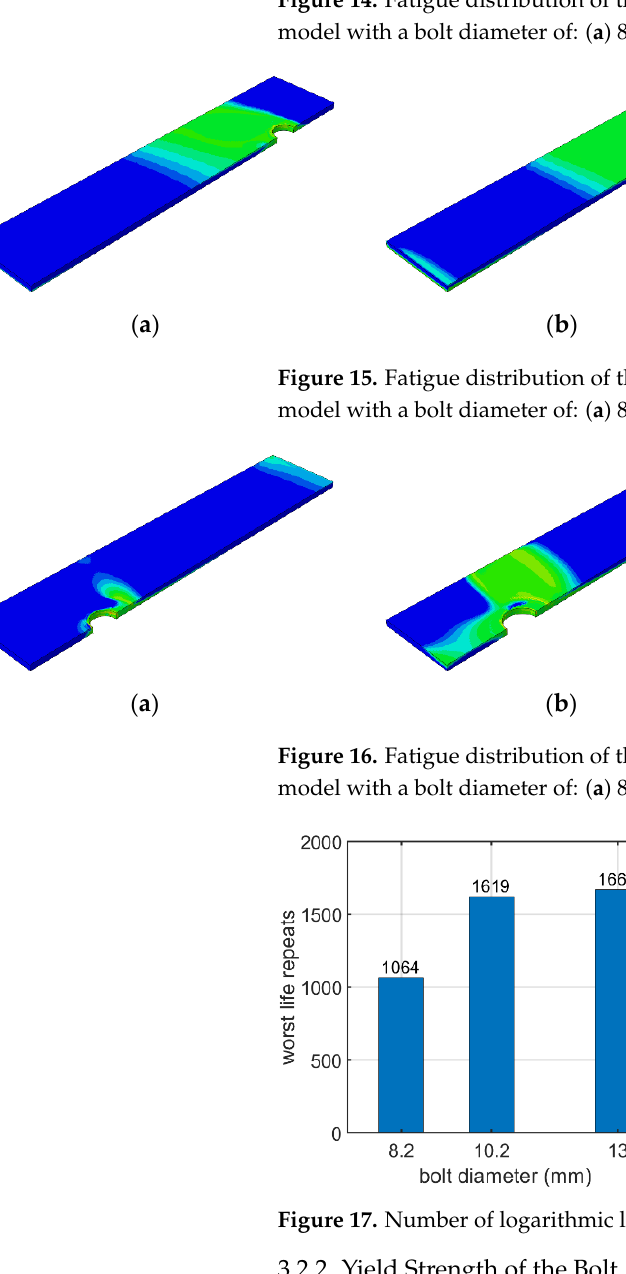
Figure 18. Number of logarithmic life repeats for parameterizing the yield stress of the nutless bolt. 3.2.3. Coefficient of Friction Another parameter analyzed was the coefficient of friction. The contact conditions for the nutless bolt connection are described in Section 2.1. In this case, five values of the coefficient of friction were analyzed: 0.05, 0.08, 0.10, 0.12, and 0.15. In Figure 19, the loga- rithmic life repeats obtained for the analyzed parameters are presented. The values pre- sented are the minimal values of the logarithmic life repeats taken for each connection from the fatigue distribution (not shown). Figure 19. Number of logarithmic life repeats for parametrizing the coefficient of friction of the nut- less bolt.